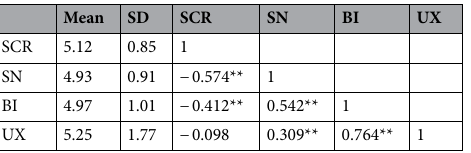
Table 4. Means, standard deviations and correlation matrix of the model constructs.